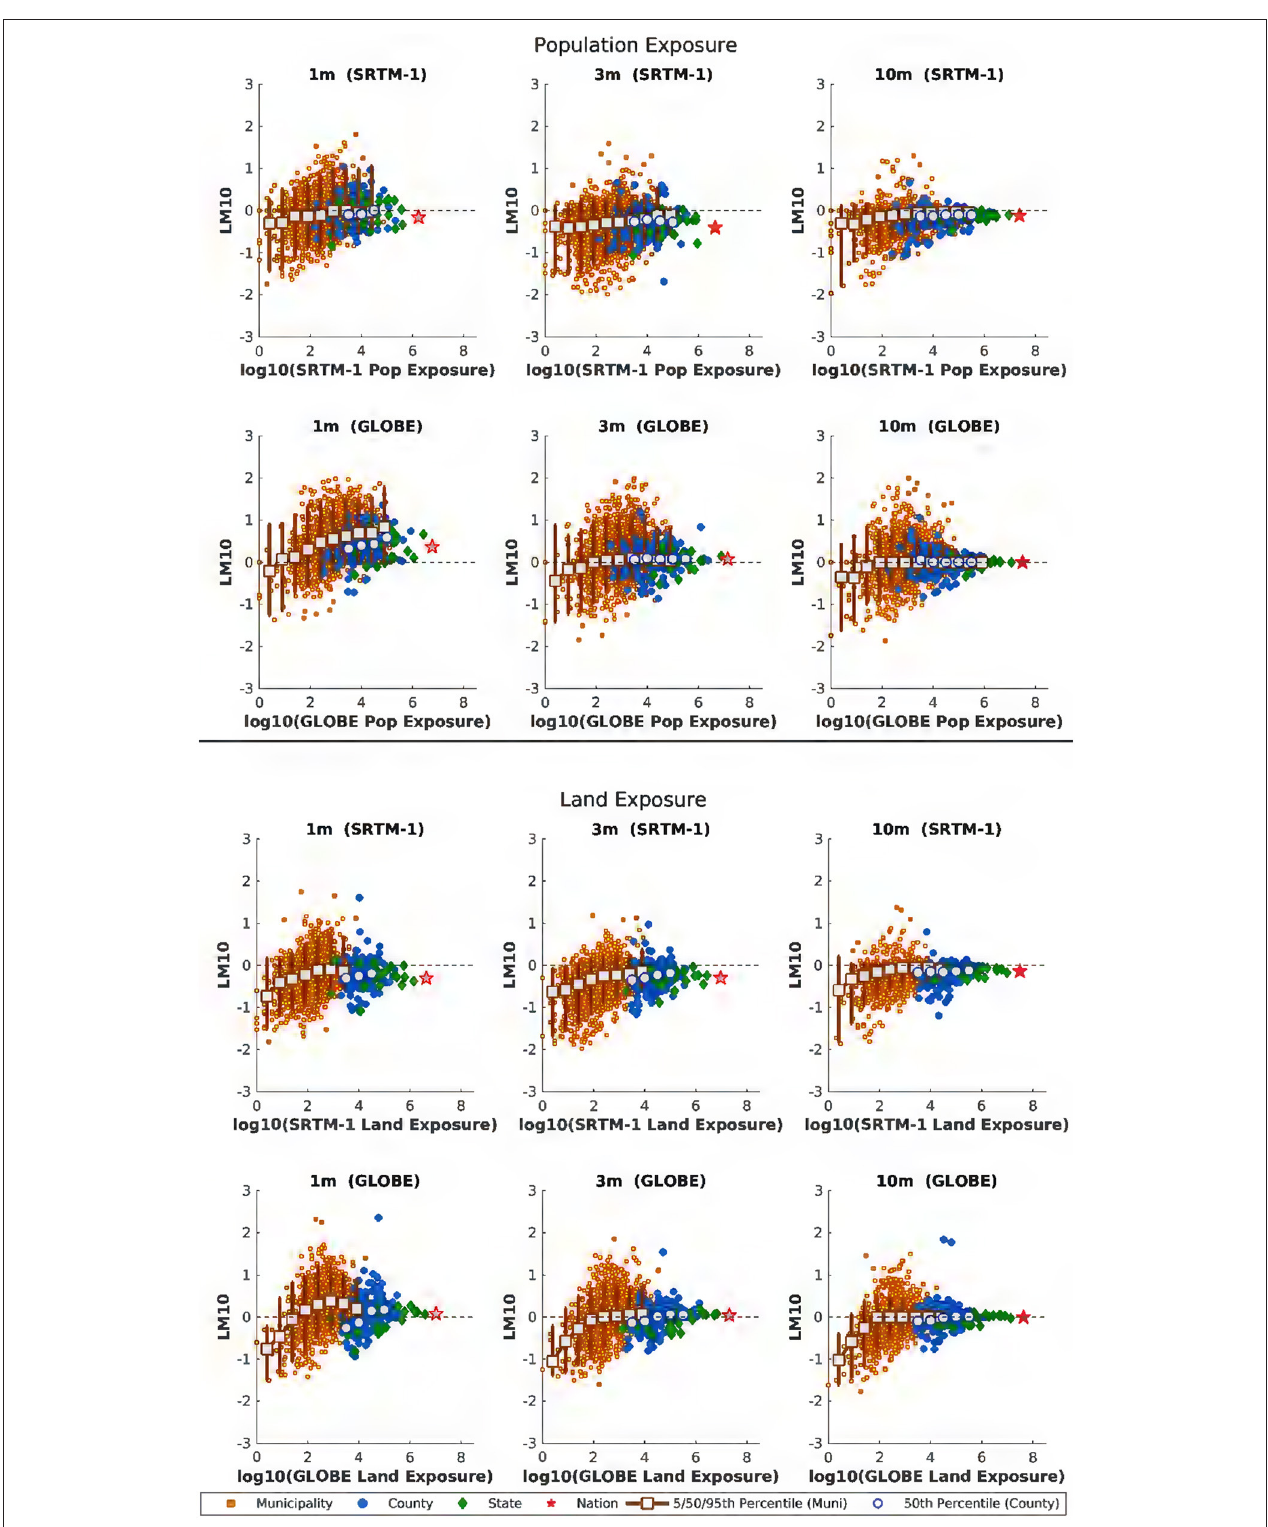
FIGURE 2 | Scatter plot of LM10 vs. estimated population (rows 1 and 2) and land (rows 3 and 4) exposure at individual places. LM10 is defined as log 10 ([SRTM1 or GLOBE exposure]/[lidar exposure]). Error bars for municipalities represent the 5/50/95th percentiles of LM10 values of neighboring points. County medians are also included, but error bars are removed to reduce clutter. Counties and municipalities with less than 1% exposure are not included.